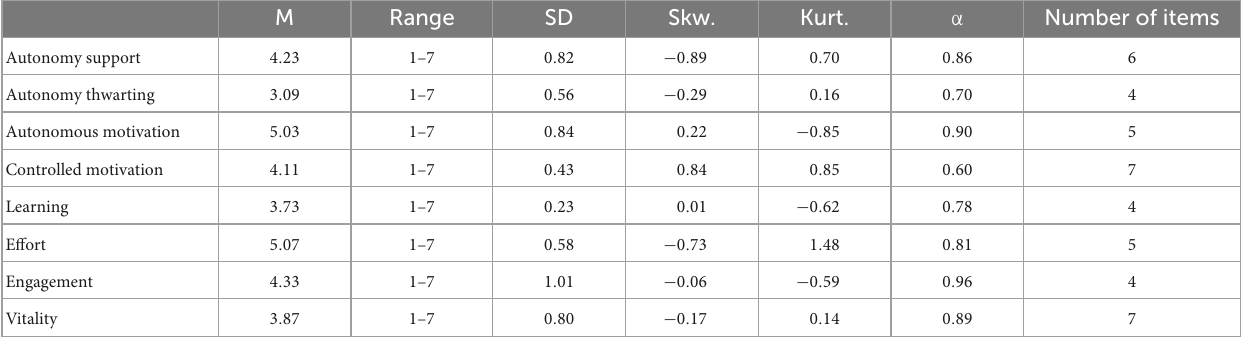
TABLE 1 Descriptive statistics for main variables.